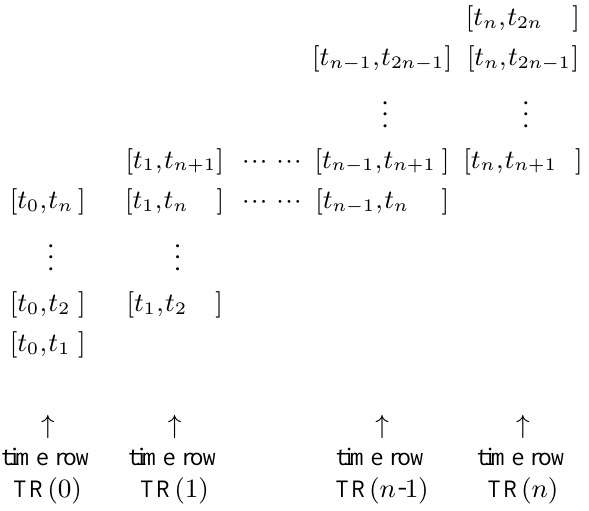
Fig. 1. Schematic presentation of the temporal singular vector diagram (TSVD). Here, each interval [ t I ,t F ] represents one singular vector calculation starting at initial time t I = t 0 + I ∆ t , I = 0 ,..,n − 1 and ending at final time t F = t 0 + F ∆ t , F = 1 ,.., 2 n , F > I . 96 different initial times and 96 different simulation